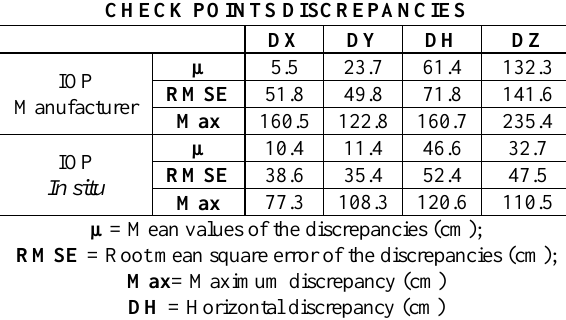
Table 4. Results of discrepancies analysis performed in check points from two ISO experiments